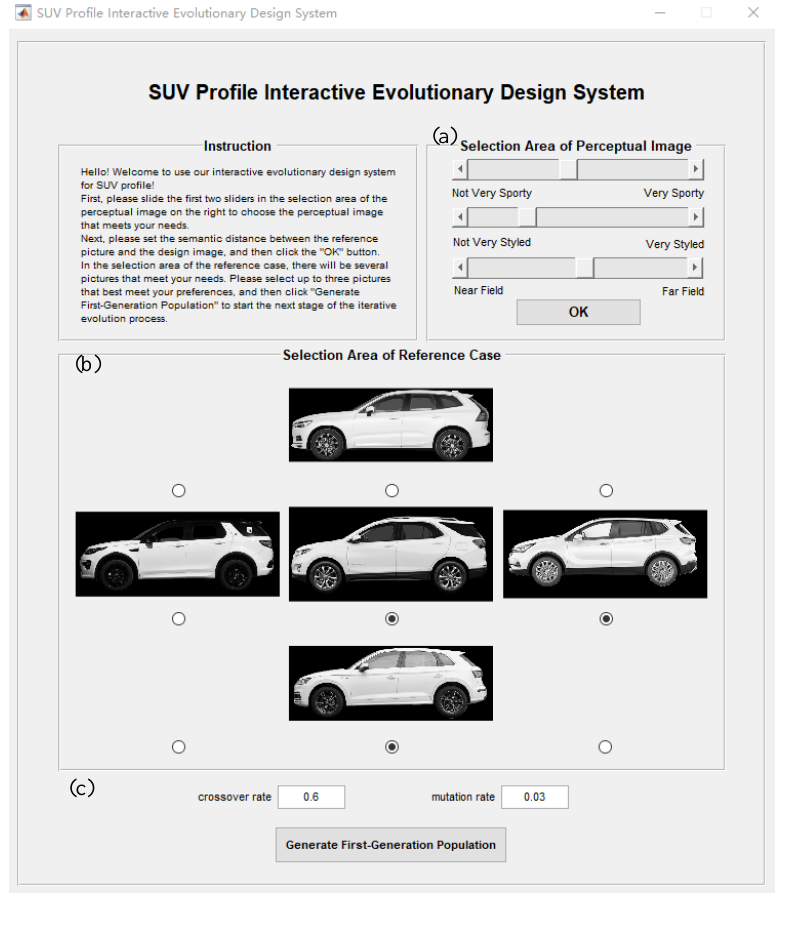
Figure 5. Creating interface to associate dissimilar information: ( a ) Part A, ( b ) Part B, and ( c ) Part C.